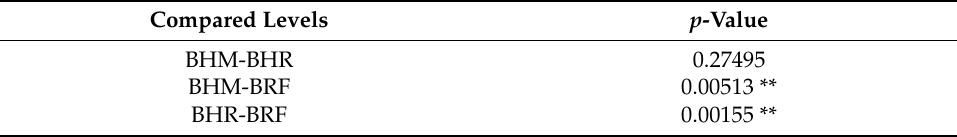
Table 8. Results of the analysis ANOVA for the